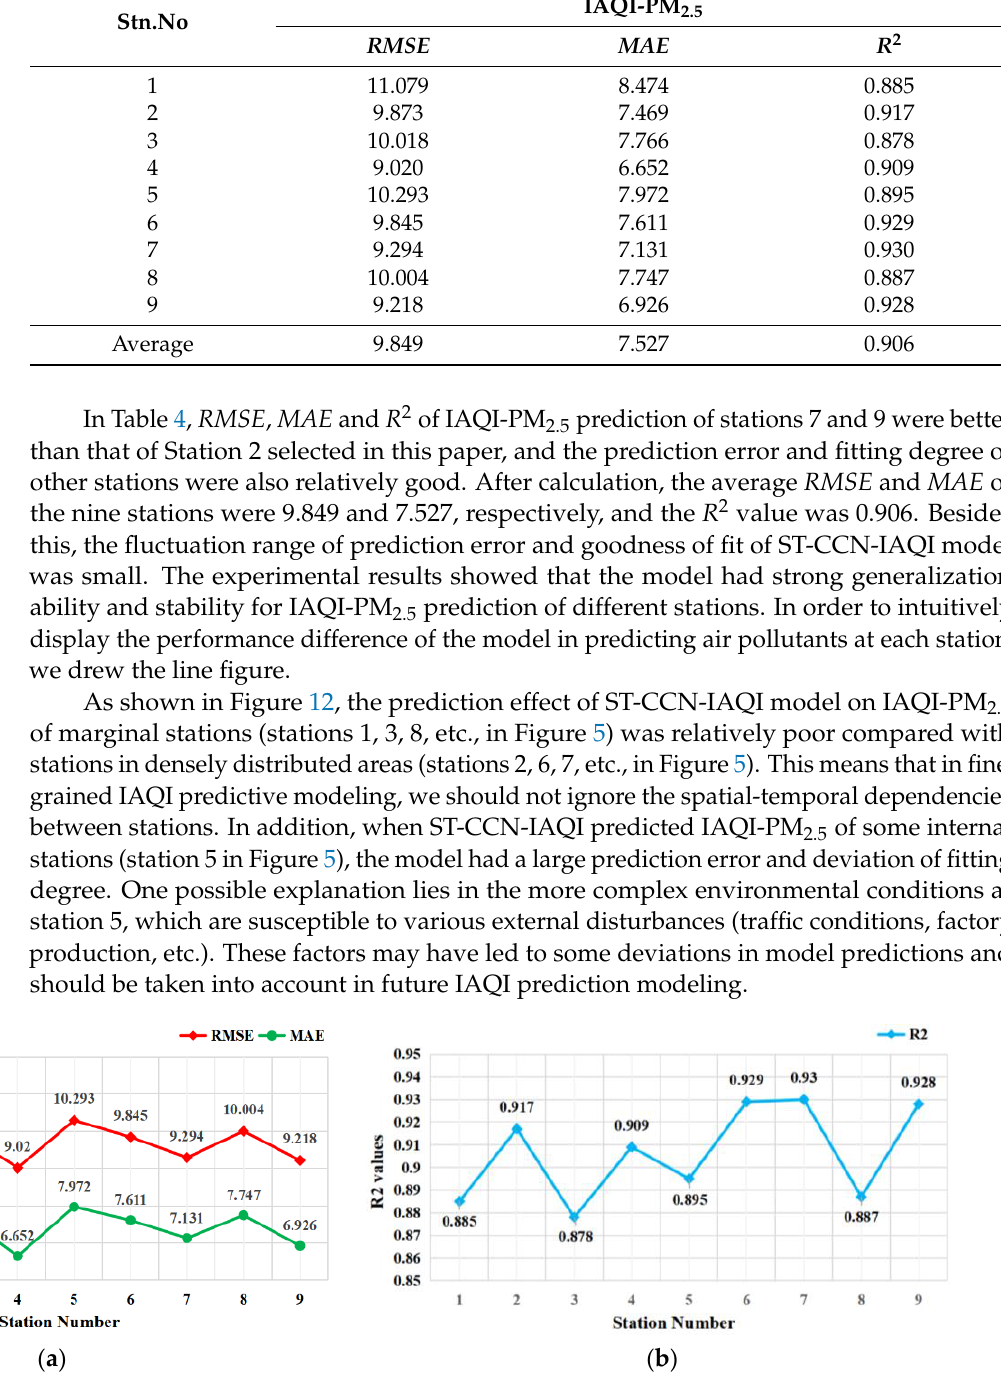
Table 4. Comparison of prediction accuracy of all stations. Stn.No